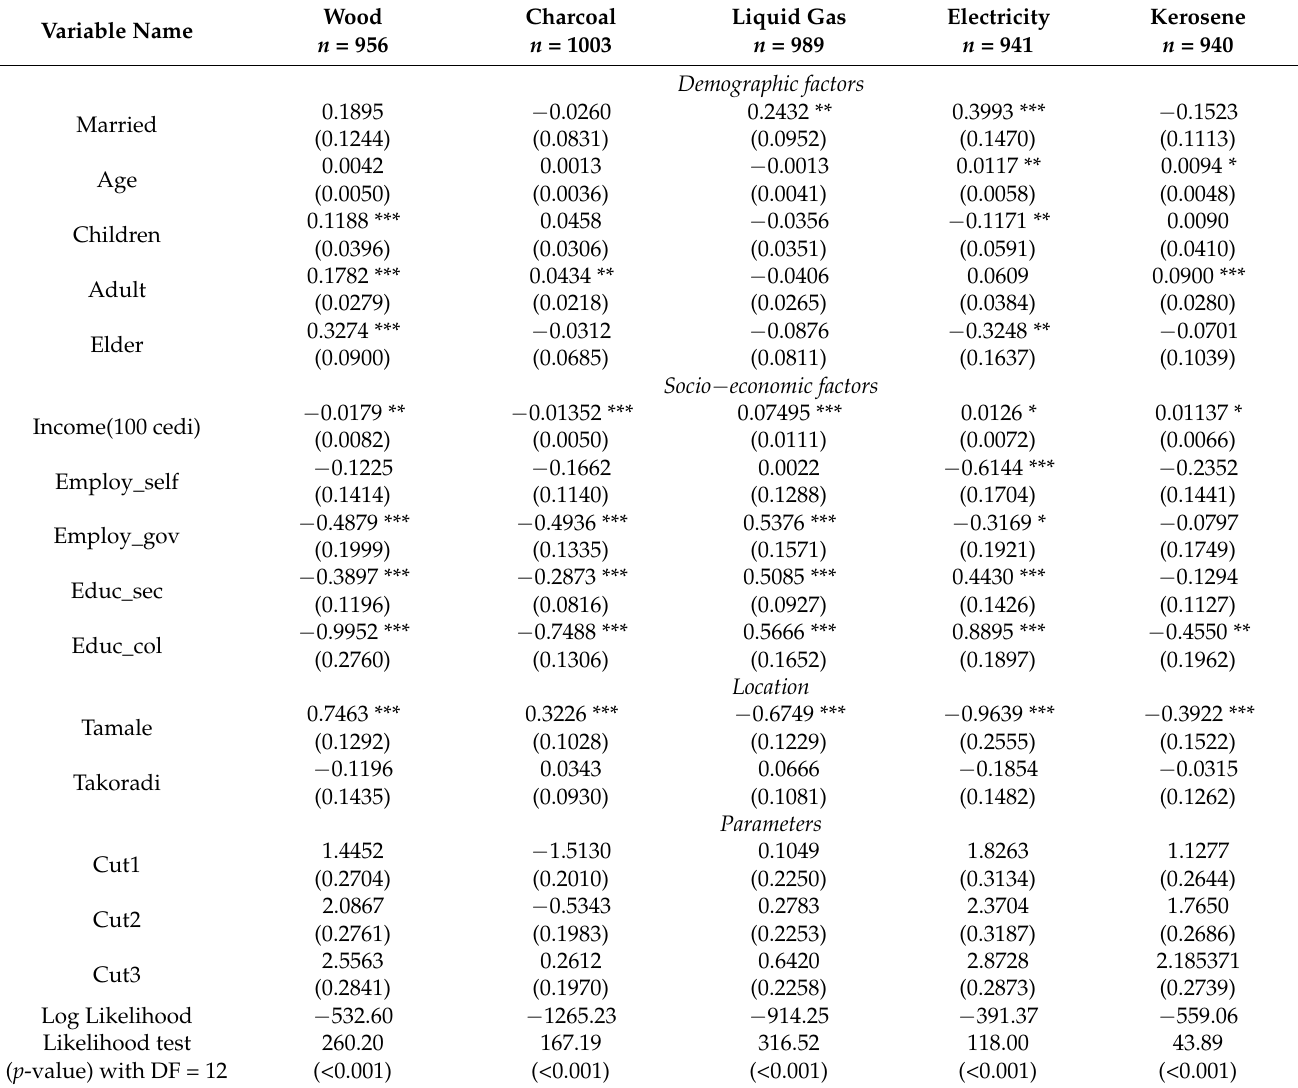
Table 4. Ordered probit estimation results of the cooking fuel use frequency in urban households of